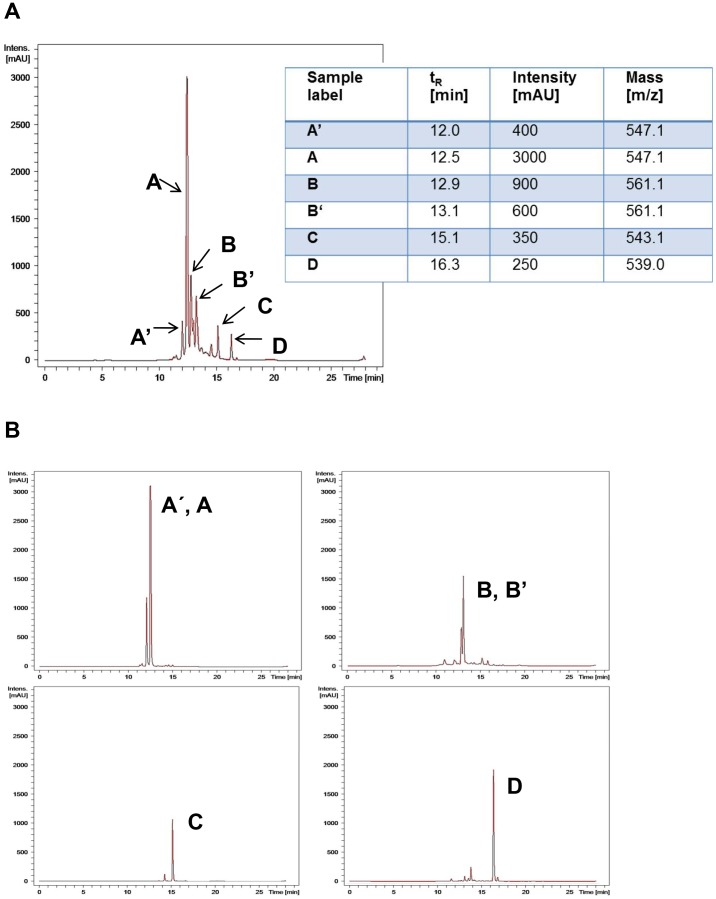
Analytical HPLC/MS profiles.(A) HPLC/MS profile of the crude extract of T. wortmannii isolated with EtOAc. (B) Chromatogram after straight phase and sephadex-G50 separation.